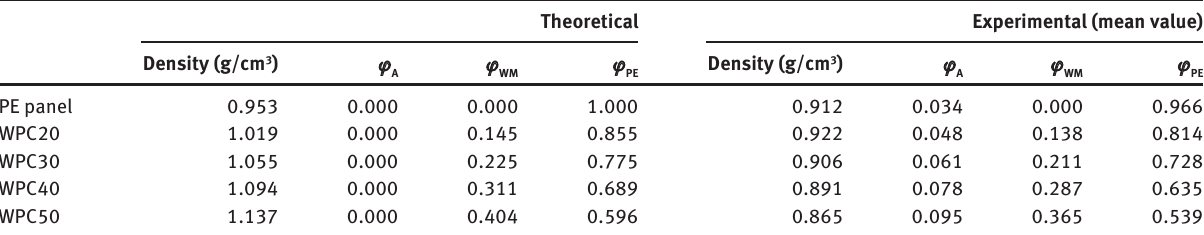
Table 4 Density, volume and mass fraction (theoretical and experimental) of the different components of the flat-pressed panels. Theoretical